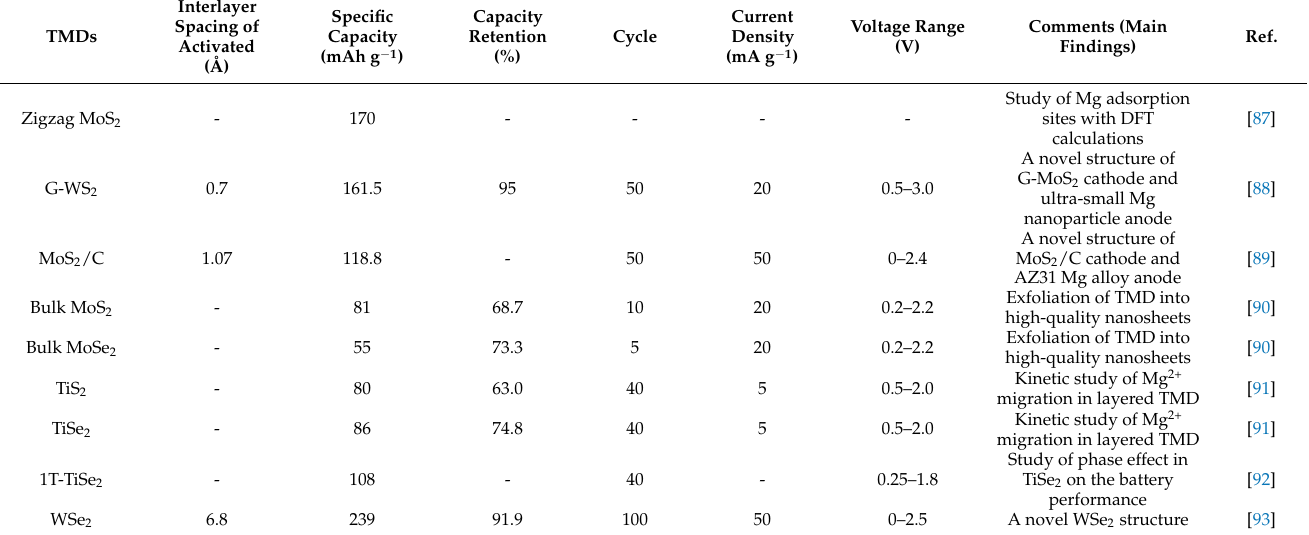
Table 3. Electrochemical performance of TMD cathodes for magnesium-ion batteries